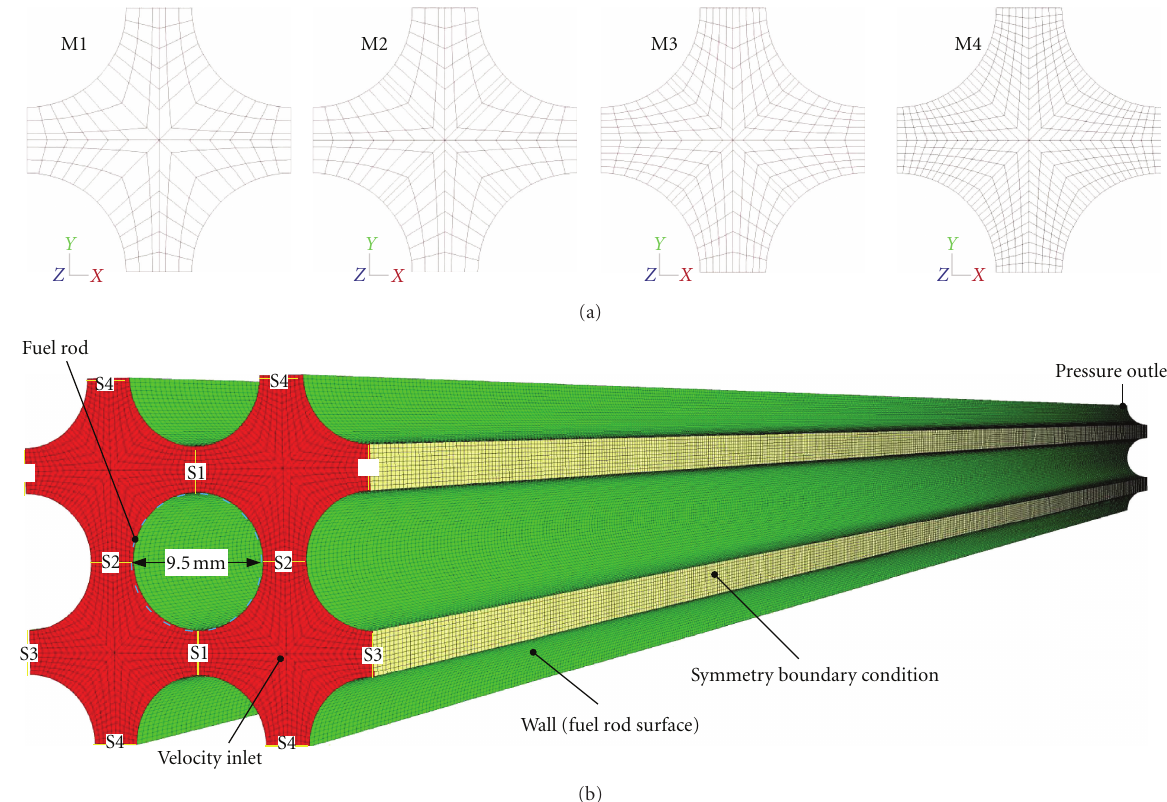
Figure 1: Computational domain and meshes.